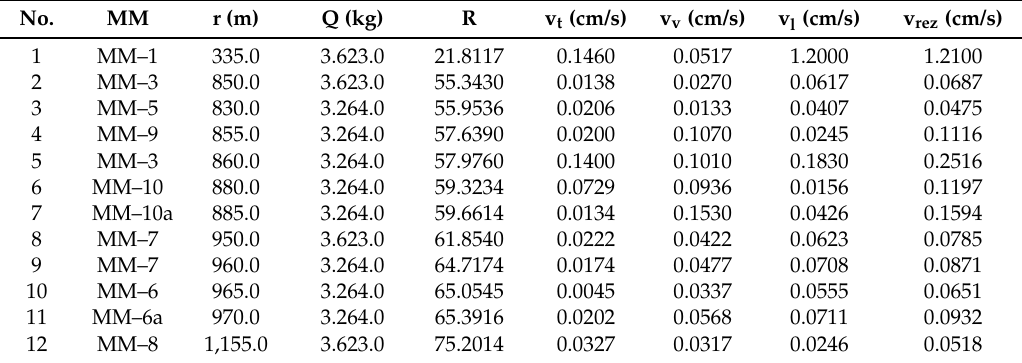
Table 4. Survey of blasting parameters and measurement results in the Kovilovaˇca Open Pit Pit.